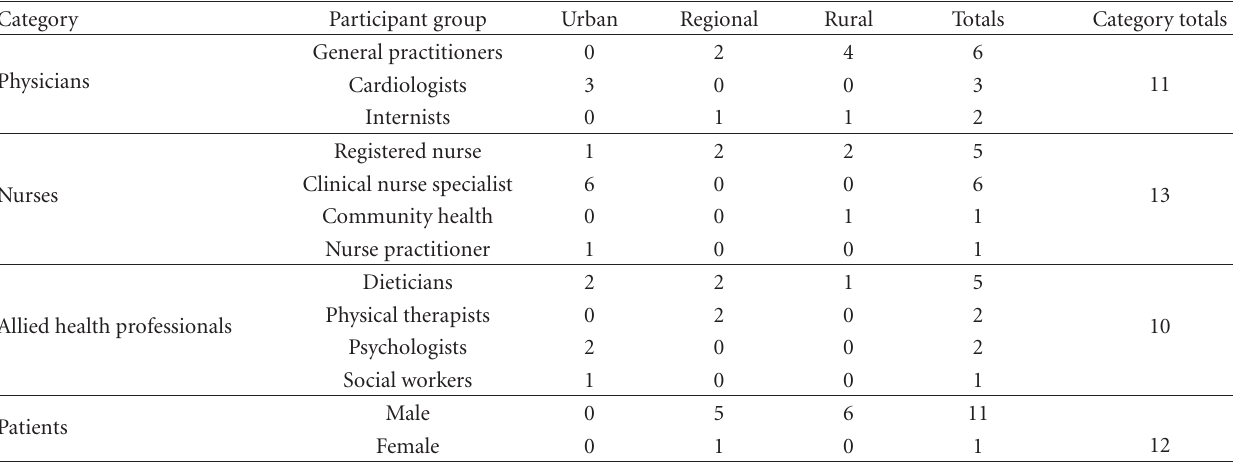
Table 1: Demographic and geographic data.